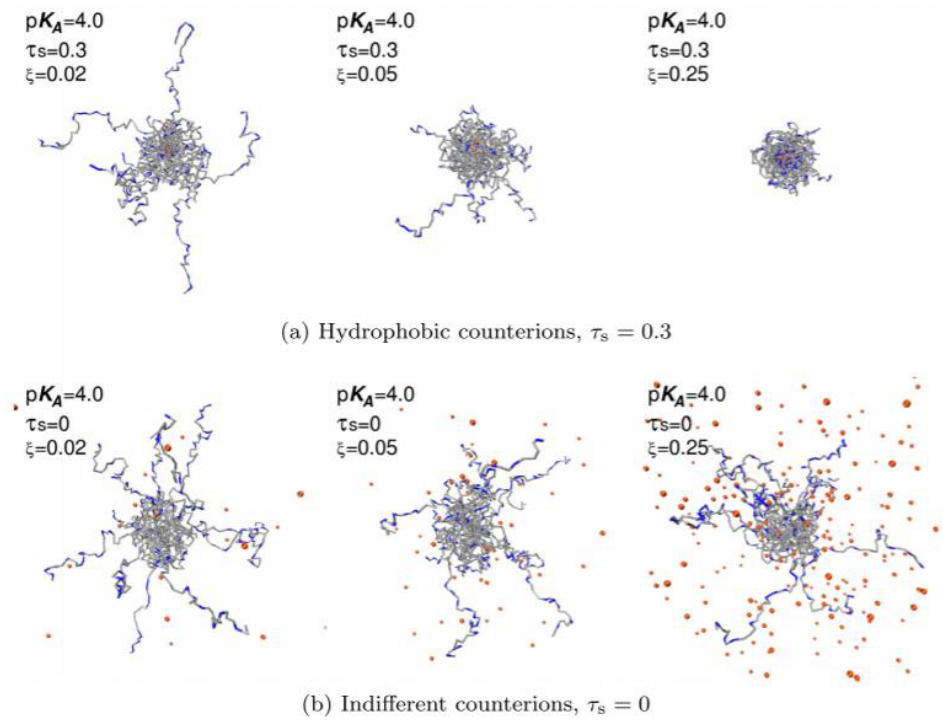
Figure 4. Snapshots from simulation of a star polyelectrolyte with 20 arms with 50 segments each and hydrophobic (top) or hydrophilic (bottom) counterions. Reprinted from [11], copyright 2019, with permission from Elsevier.